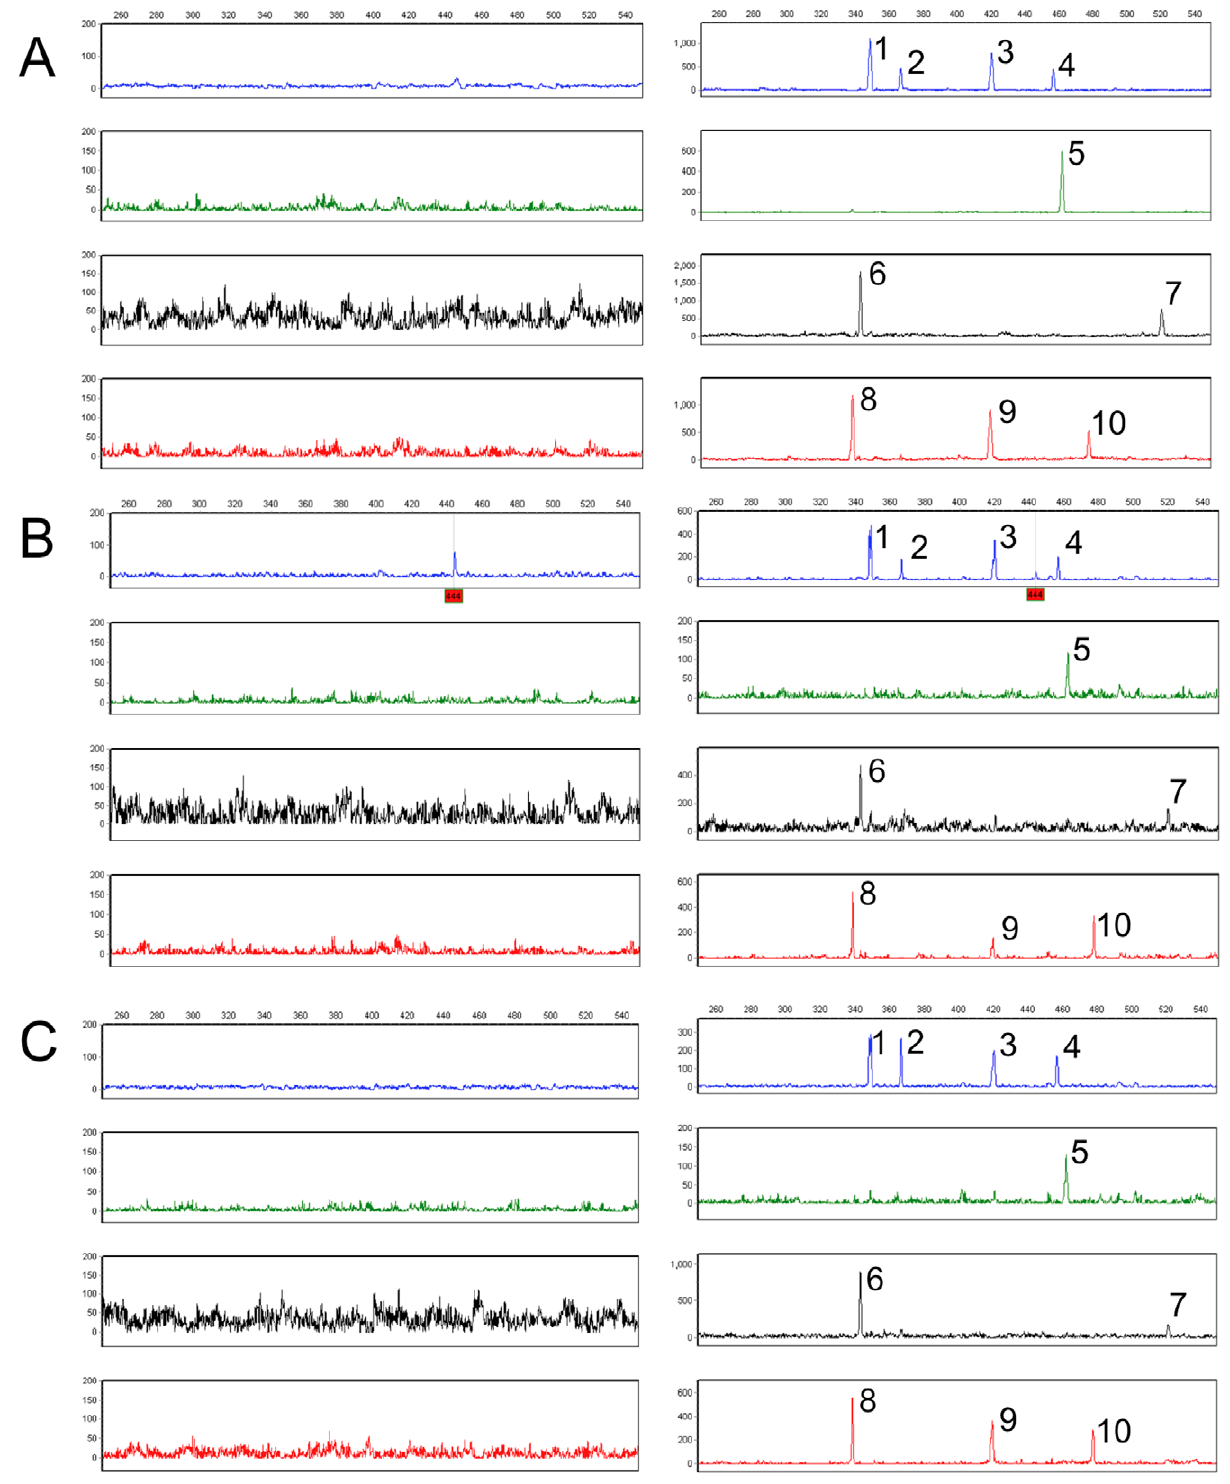
Figure 5. Efficiency and sensitivity of the 30-plex panel with real-world air filter samples. Electropherograms obtained from Pentagon filter (A); BioWatch filter I (B); and BioWatch filter II (C). Resulting profiles on the left were from amplification of DNAs purified from air filter; profiles on the right were from air filter DNAs spiked with 100 copies of Ba Sterne. Background noise was detected from direct amplification of the three air filter samples, and the 10-plex Ba -signature was generated for all Ba -spiked air filter DNA samples. The observed nonspecific peak at 444 bp (highlighted in red) was readily distinguished from the 10 specific product peaks (1-pXO1_ lef, 2- cod Y, 3- spo VT, 4- hem L, 5-pXO1_ ger XB, 6- ssp F, 7- pbp 1A, 8- yih Y, 9- BA0872, and 10- bas B).